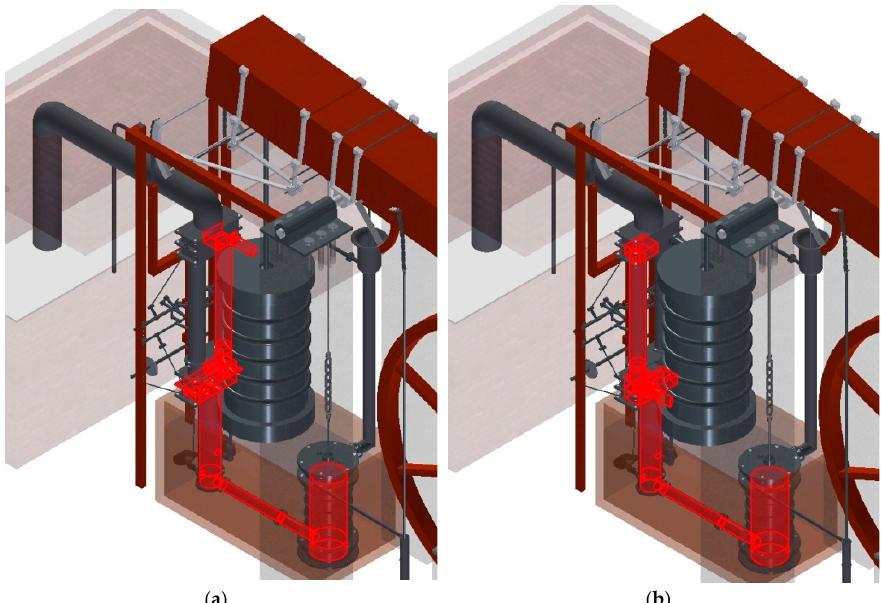
Figure 10. Lower pipe with steam at low pressure and temperature: ( a ) subjected to atmospheric pressure and ( b ) subjected to a pressure below atmospheric pressure (by condensation).